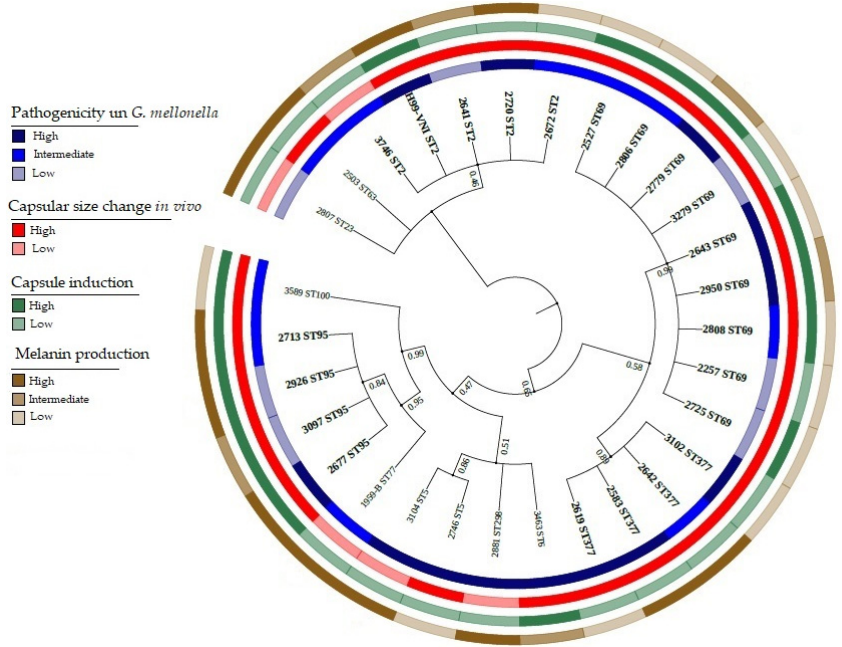
Figure 5. Summary of the main genotypic and phenotypic results obtained in 29 clinical isolates of C. neoformans var. grubii : Phylogenetic analysis, pathogenicity in G. mellonella , capsule size, and melanin production. The evolutionary history was derived using the maximum-likelihood method based on the Jukes–Cantor model using concatenated nucleotide sequences of 7 loci. Bootstrap values are displayed for each branch (1000 repeats).